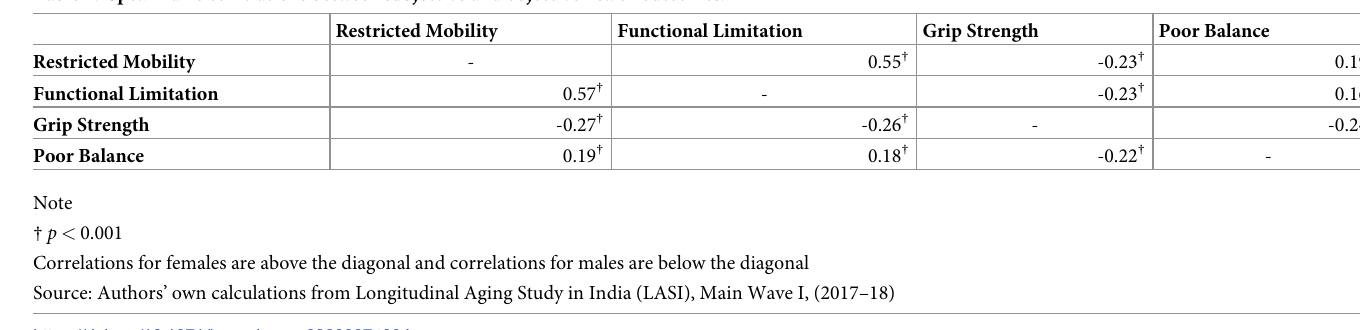
Table 4. Spearman’s correlations between subjective and objective health